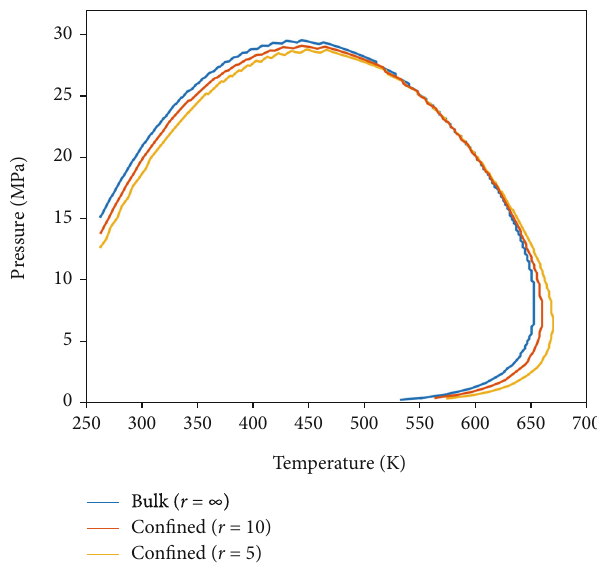
Figure 4: Phase envelope for an Eagle Ford oil considering capillarity at di ff erent pore